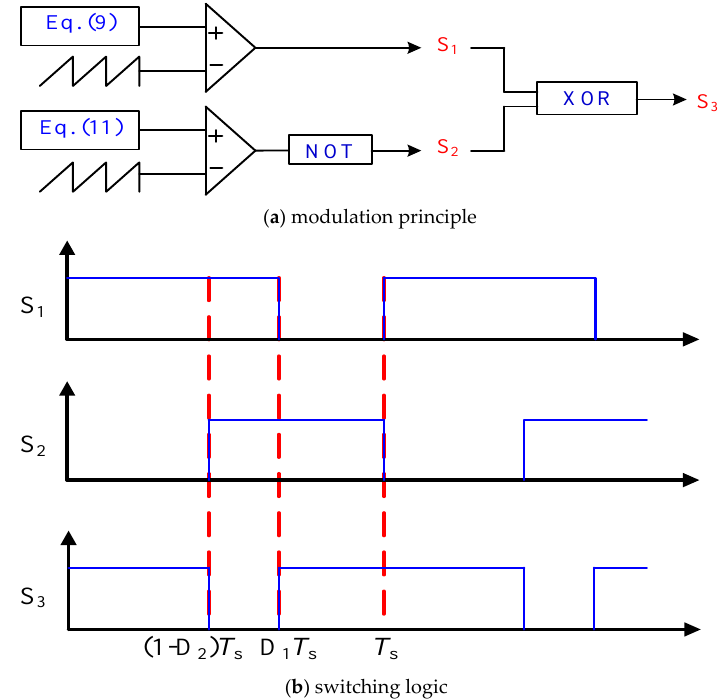
Figure 4. Modulation strategy of proposed inverter.